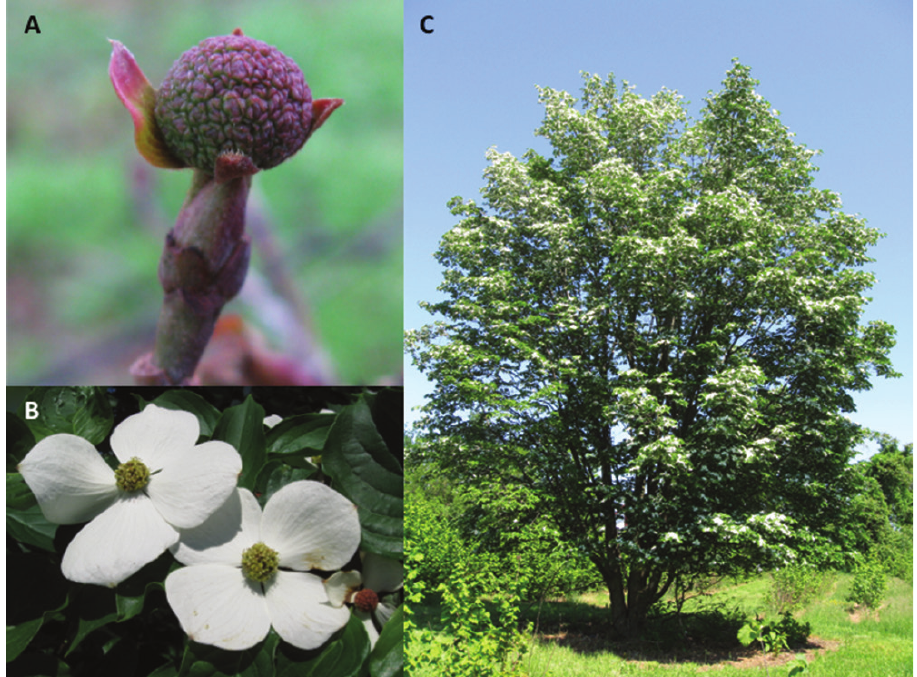
Figure 2. Photos of Cornus × elwinortonii. A Close up of dormant inflorescent bud; note the exposed flower buds and partially developed floral bracts B Flowers and floral bract display after dehiscence; note frost damaged inflorescence on the far right C Habit of mature plant. Photograph by Thomas